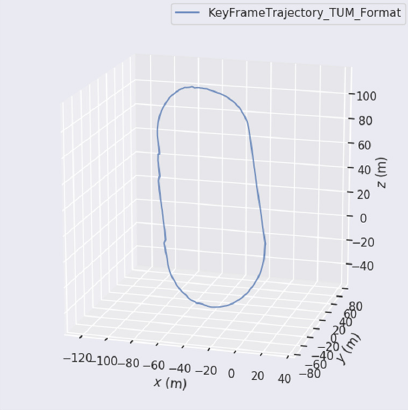
Figure 11. Our algorithm positioning the trajectory map.